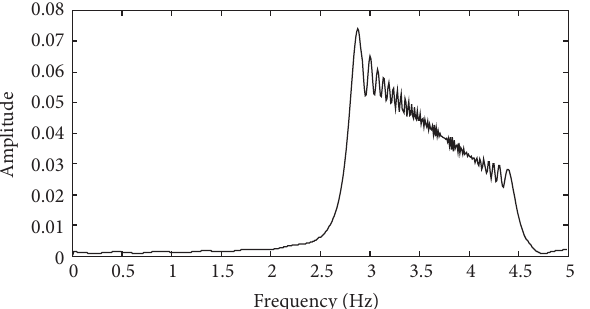
Figure 6: FFT of displacement response of case 1.